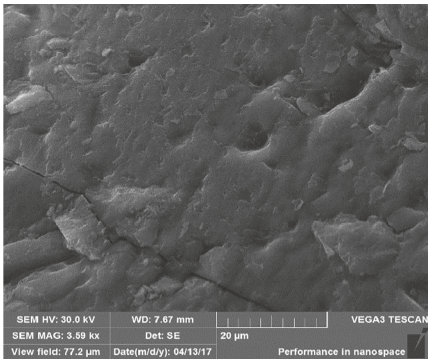
Figure 15: SEM image of tonalite after freeze-thaw cycling with a minimum temperature of − 40 °